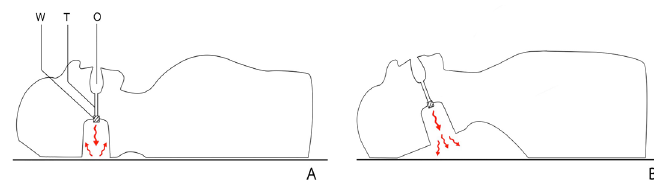
Figure 3. A and B show the mechanism that senses the breathing: O = oral cavity; T = tube; W = whistle. A) Blowing into the mouth without the chin lift maneuver limits the sound from the manikin; B) A loud whistle sound is produced when blowing into the mouth after the chin lift maneuver.